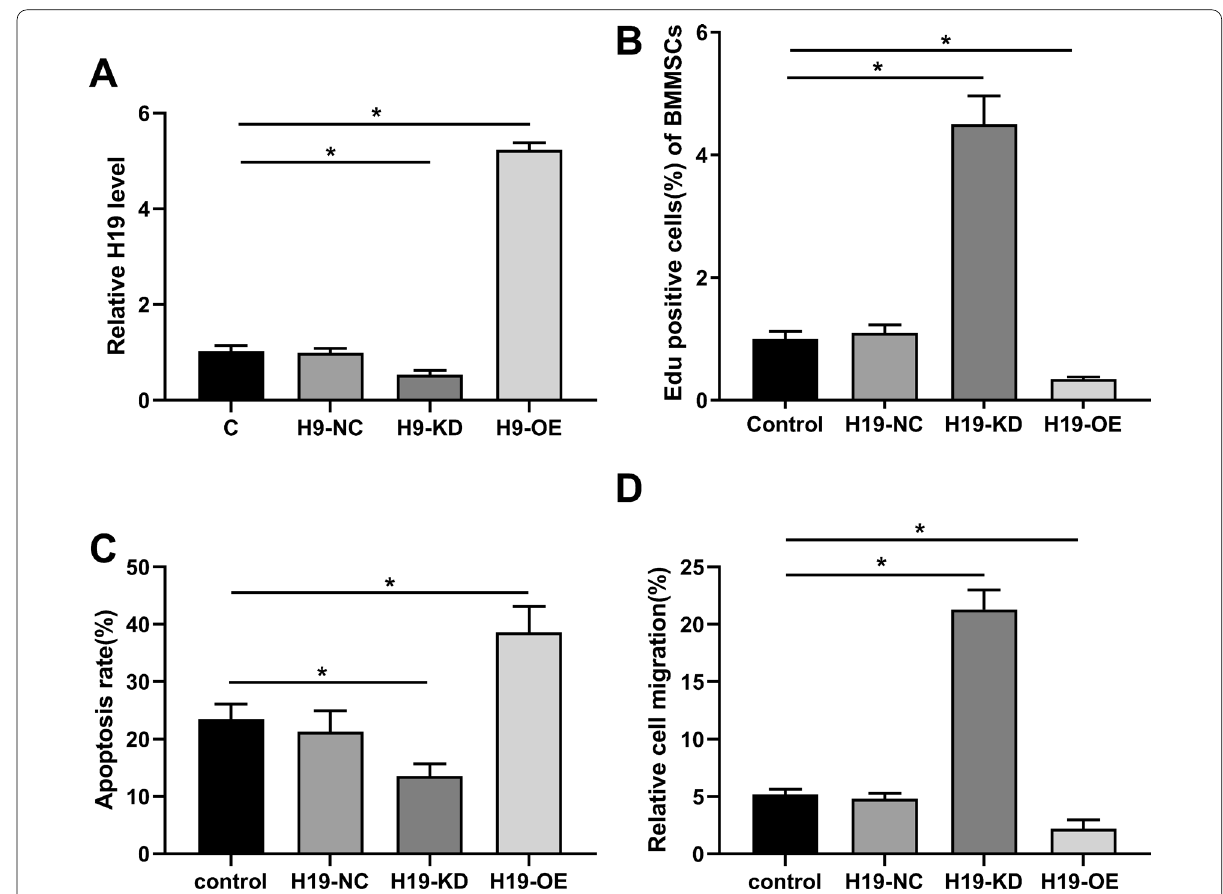
Fig. 2 H19 inhibited proliferation and migration and promoted apoptosis of BMMSCs in vitro. The BMMSCs were transfected with H19-NC, H19-OE or H19-KD, and normal BMMSCs as control. A H19 level was measured by qPCR at 24 h of post-transfection to confirm the success of transfections. B Proliferation of cells in these four groups were measured by the EdU assay. C Apoptotic rate of cells in these four groups. D Migration ability of BMMSCs in these four groups were detected by migration assay. n 6. *P < 0.05, **P < =